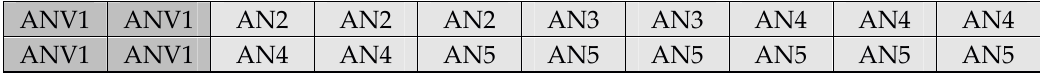
Figure 9. Proportional assignment of nozzles to the ANC.